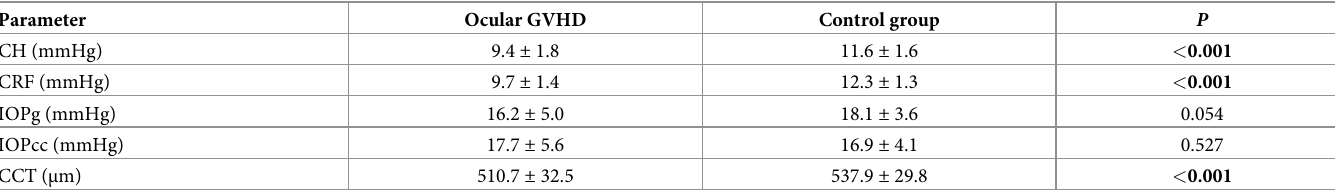
CCT: Central corneal thickness; GVHD: Graft versus-host disease; CH, corneal hysteresis; CRF, corneal resistance factor; IOPg; Goldmann-correlated intraocular pressure; IOPcc, corneal-compensated intraocular pressure.